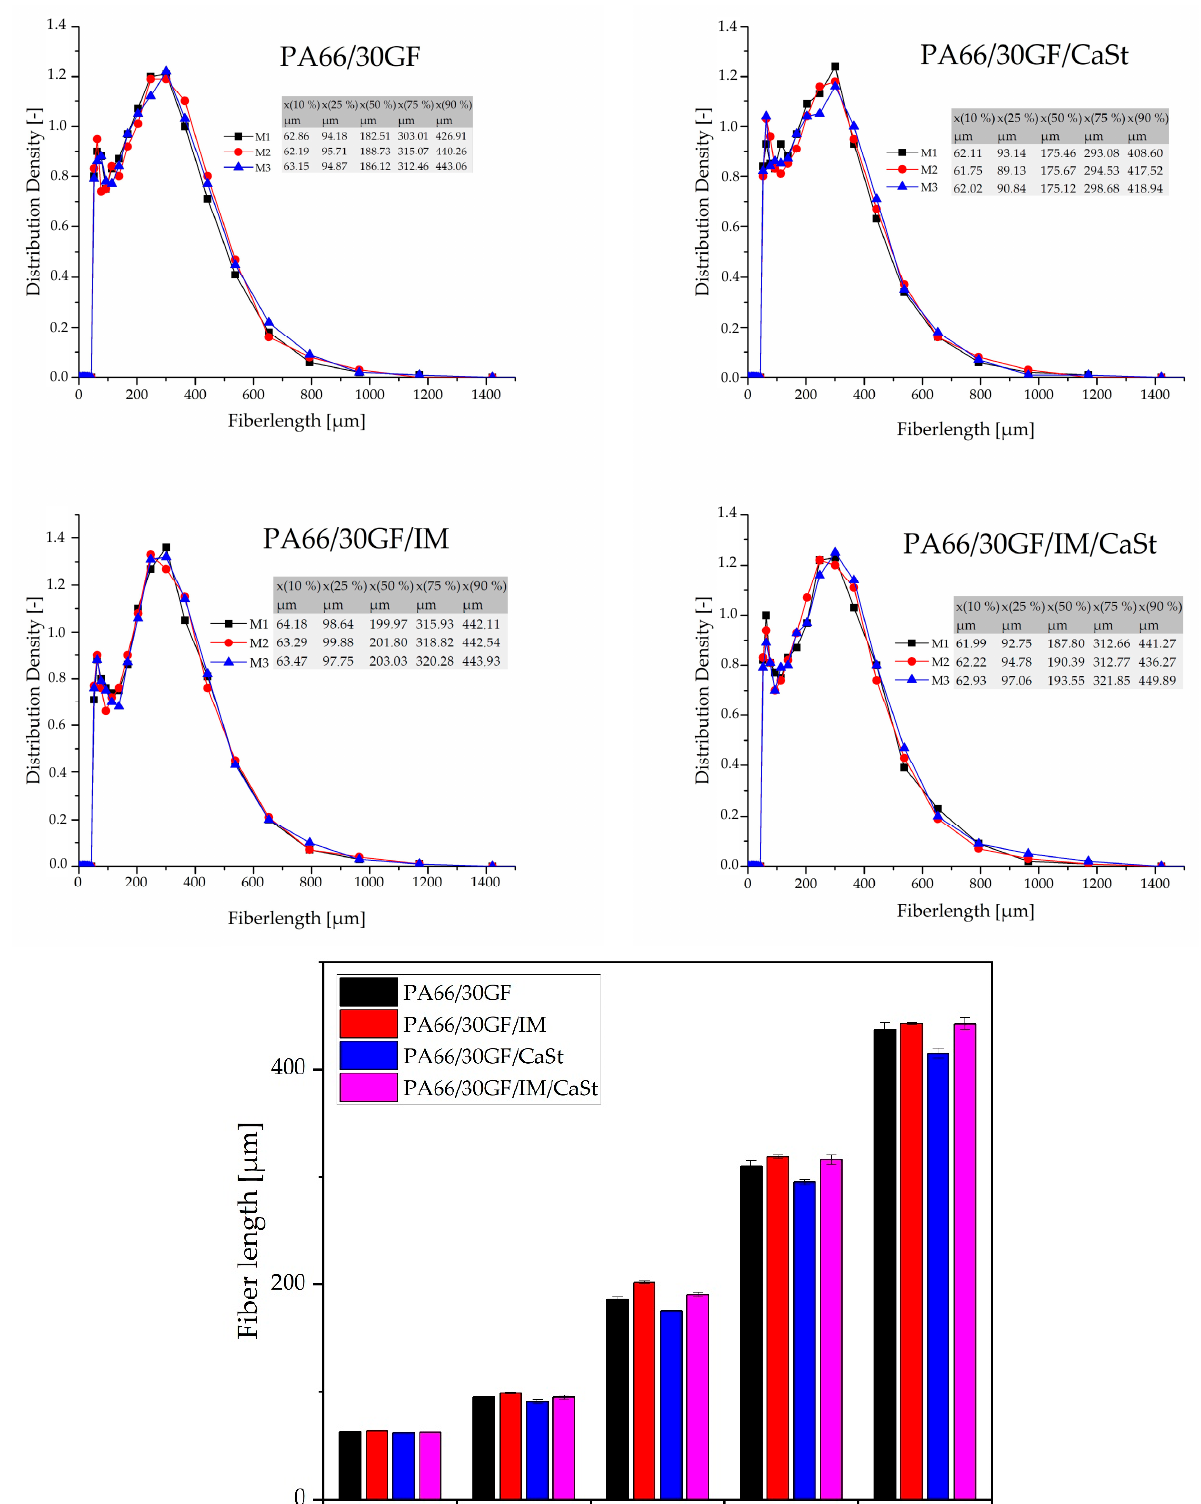
Figure 4. Results of the distribution density of measured fiber length from dynamic image analy- sis.